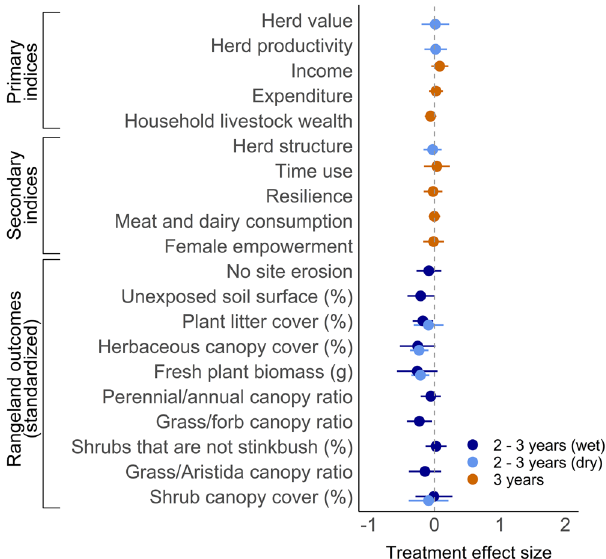
Fig. 3 Effect of community-based rangeland management (CBRLM) on 20 cattle, economic, and rangeland outcomes. Dark and light blue markers denote results 2 – 3 years after program end (2016, 2017) and dark orange markers denote results 3 years after program end (2017). For each outcome, the mid-point is the standardized treatment effect size with a corresponding 95% con fi dence interval. Supporting statistical results are shown in Table